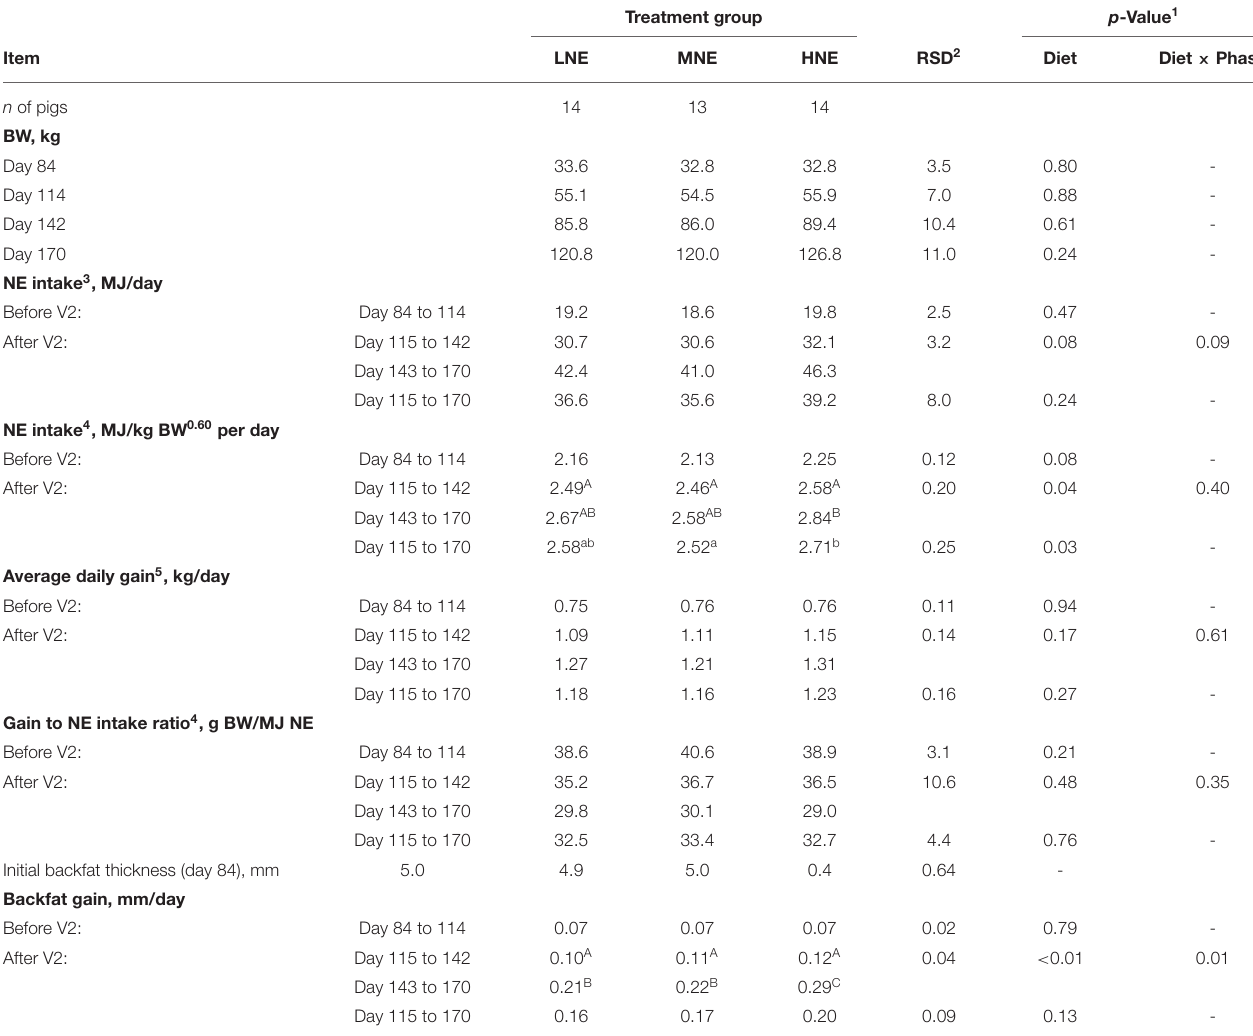
TABLE 2 | Effect of dietary net energy concentration on feed intake and growth performance in immunocastrated pigs. Treatment group p -Value